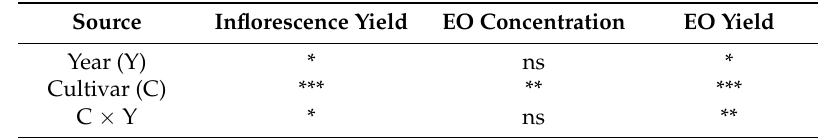
Table 7. Statistical significance (ANOVA) of year, cultivar, and their interaction on inflorescence yield, essential oil concentration in the inflorescences (EO concentration), and essential oil yield (EO yield). Source Inflorescence Yield EO Concentration EO Yield Year (Y) * ns * Cultivar (C) *** ** *** C × Y * ns ** *, **, and *** indicate significance at the p < 0.05, 0.01 and 0.001 levels, respectively. ns = not significant.